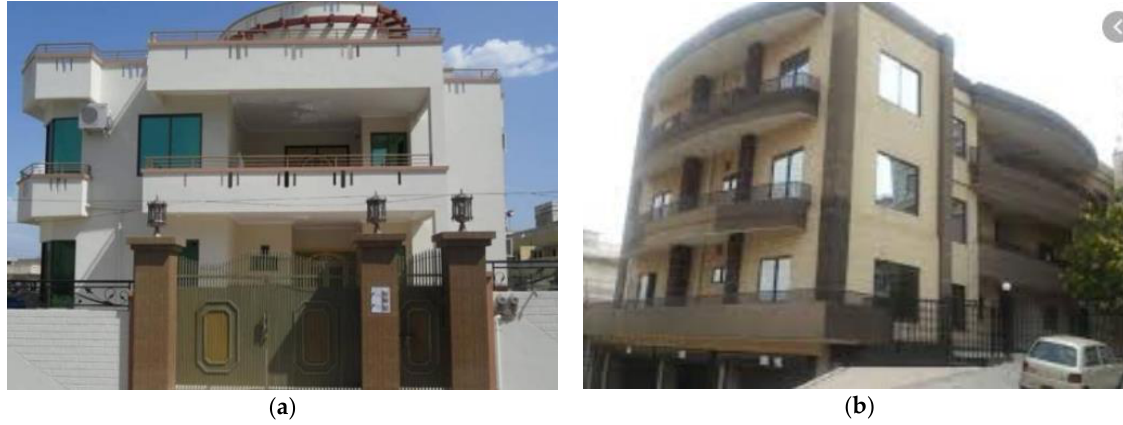
Figure 4. Typical house and residential flats in Mirpur city. ( a ) Double-story house and ( b ) Flats.